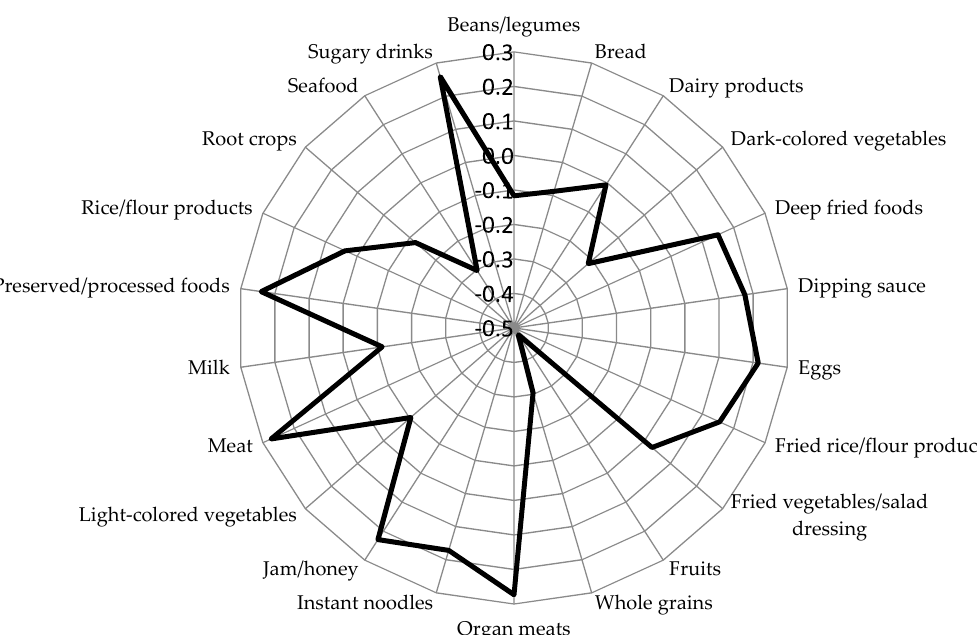
Figure 2. Spider-web diagram of factor loadings of inflammatory dietary pattern identified by reduced rank regression model. Factor loadings are correlations between food groups and dietary pattern scores.